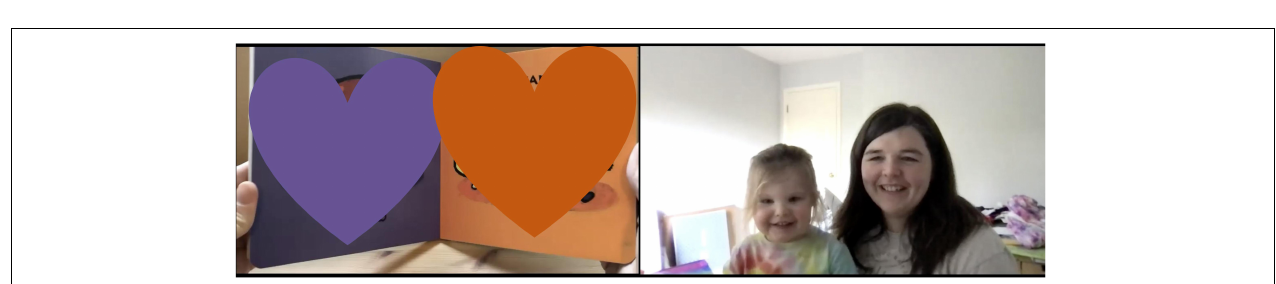
FIGURE 4 | Issue with size of participant’s screen in Zoom.